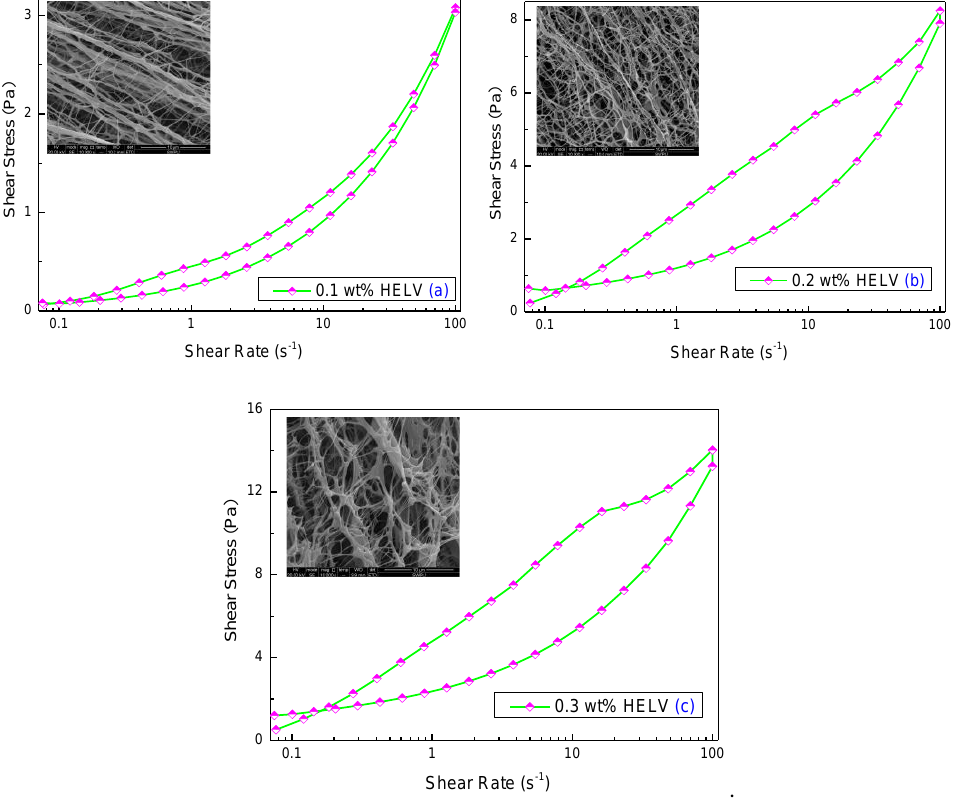
Figure 11. The thixotropy curves for the study ′ s HELV fluids: ( a ) 0.1 wt %; ( b ) 0.2 wt %; ( c ) 0.3 wt %.